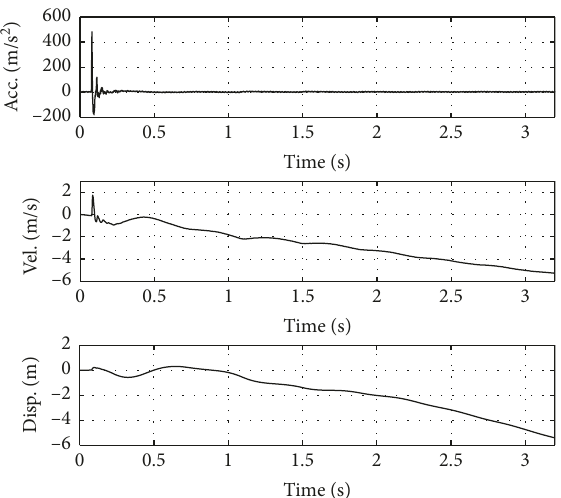
Figure 5: The original shock acceleration signal and its integrations (under test condition 2).